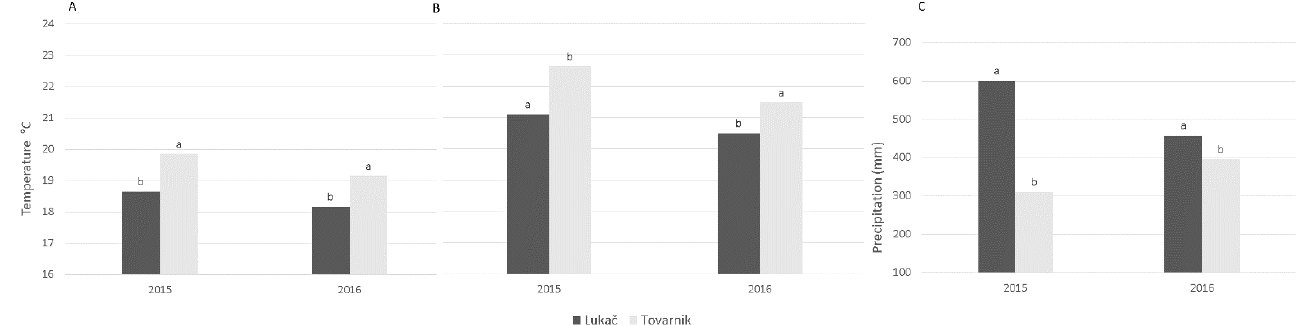
Figure 2. Climate conditions of ( A ) average air temperature, ( B ) average soil temperature, and ( C ) precipitation) in Lukaˇc and Tovarnik monitored at nearest climate stations and results of statistical analysis. Values followed by the same letters are not significantly different ( p > 0.05; HSD test) between locations. Significant differences between years were not established. Table 1. Crop stand (number of plants/10 m 2 ) established on different treatments in different plant developmental stages